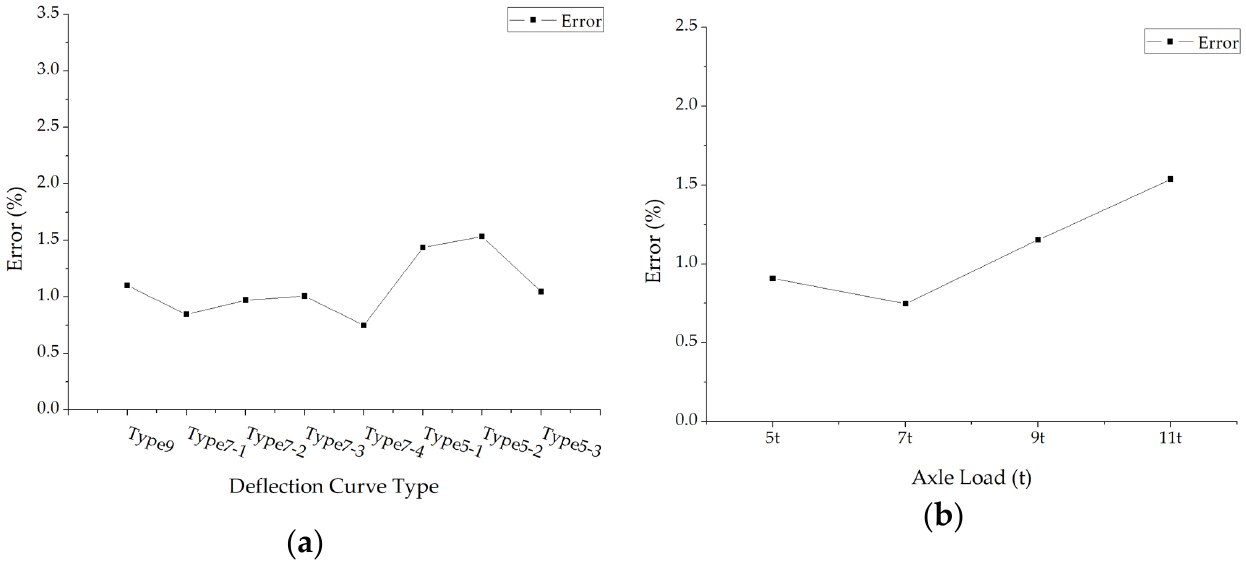
Figure 6. The average errors of back calculated surface modulus: ( a ) The average errors under different deflection curve types; ( b ) The average errors under different axle loads.